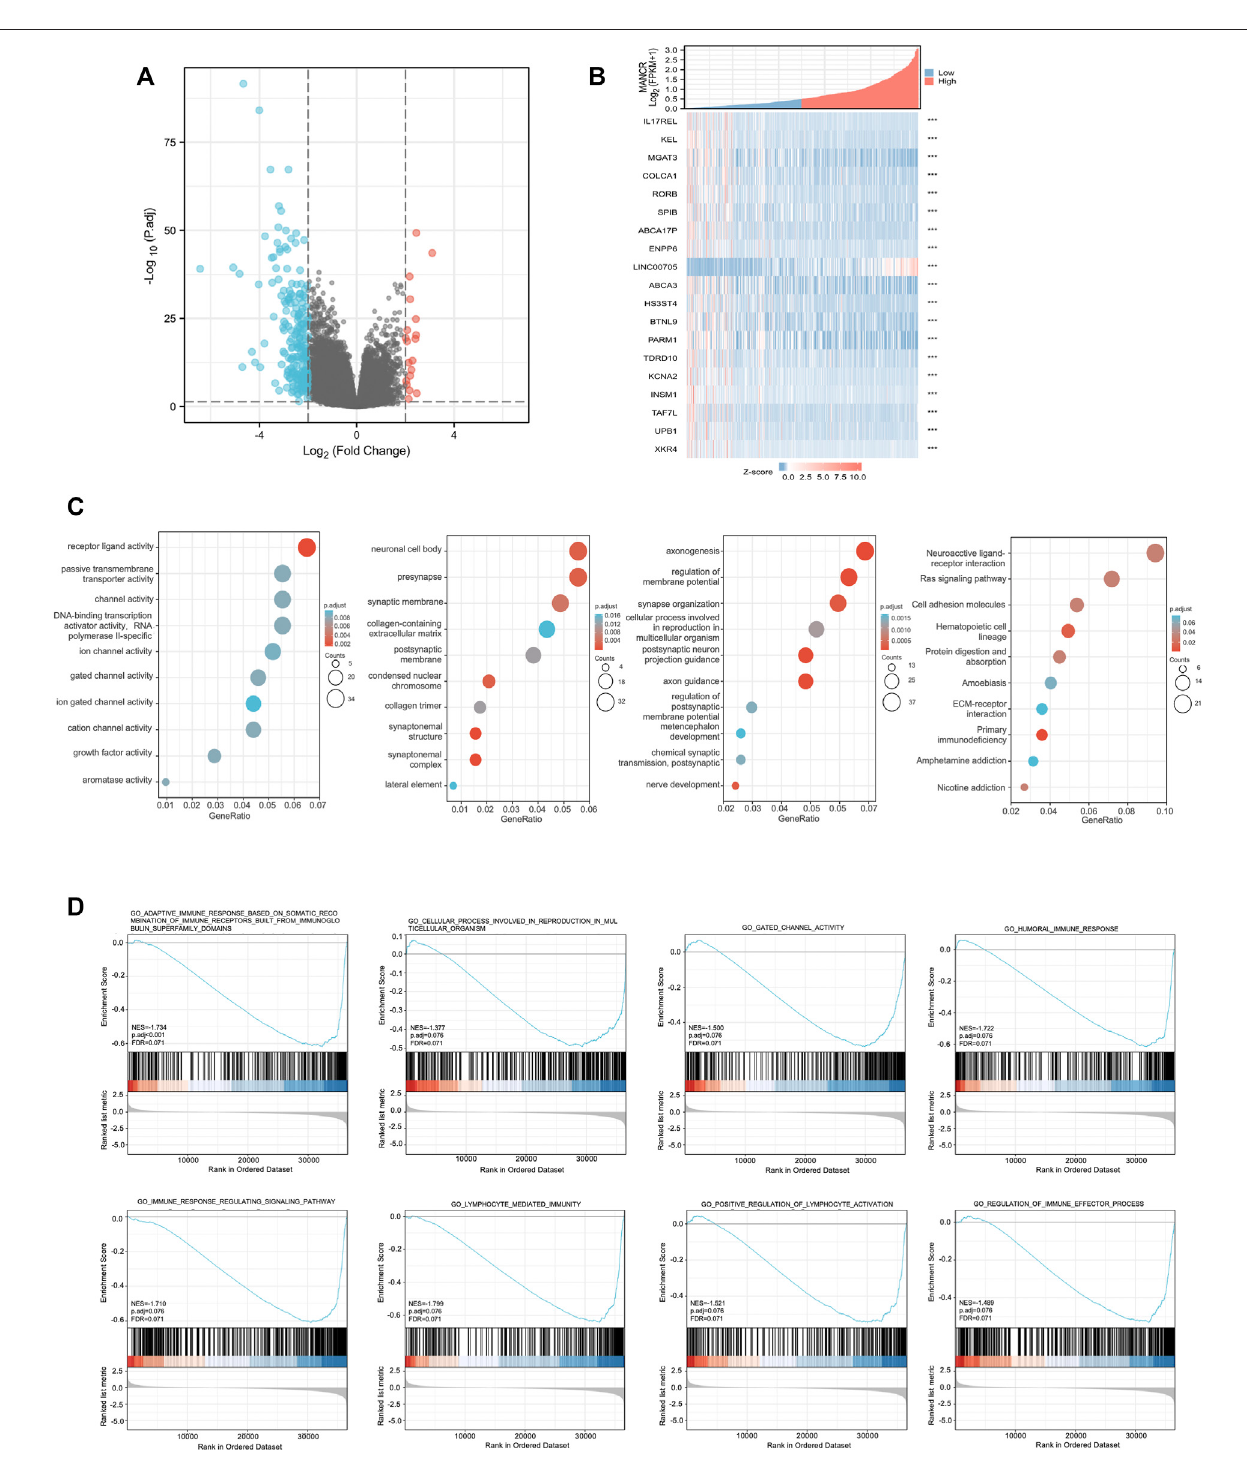
FIGURE 5 | Differentially expressed genes (DEGs) in different MANCR expression samples and functional cluster analysis. (A) Volcano map of DEGs showed that 19 genes were upregulated and 205 genes were downregulated respectively (|log2FC| > 2, adjusted p- value < 0.05). (B) Heat map showed that 19 genes were most signi fi cantly related to MANCR expression. (C) Signi fi cantly enriched GO and KEGG annotations of MANCR-related genes. (D) Enrichment gene analysis by GSEA in HNSCC.